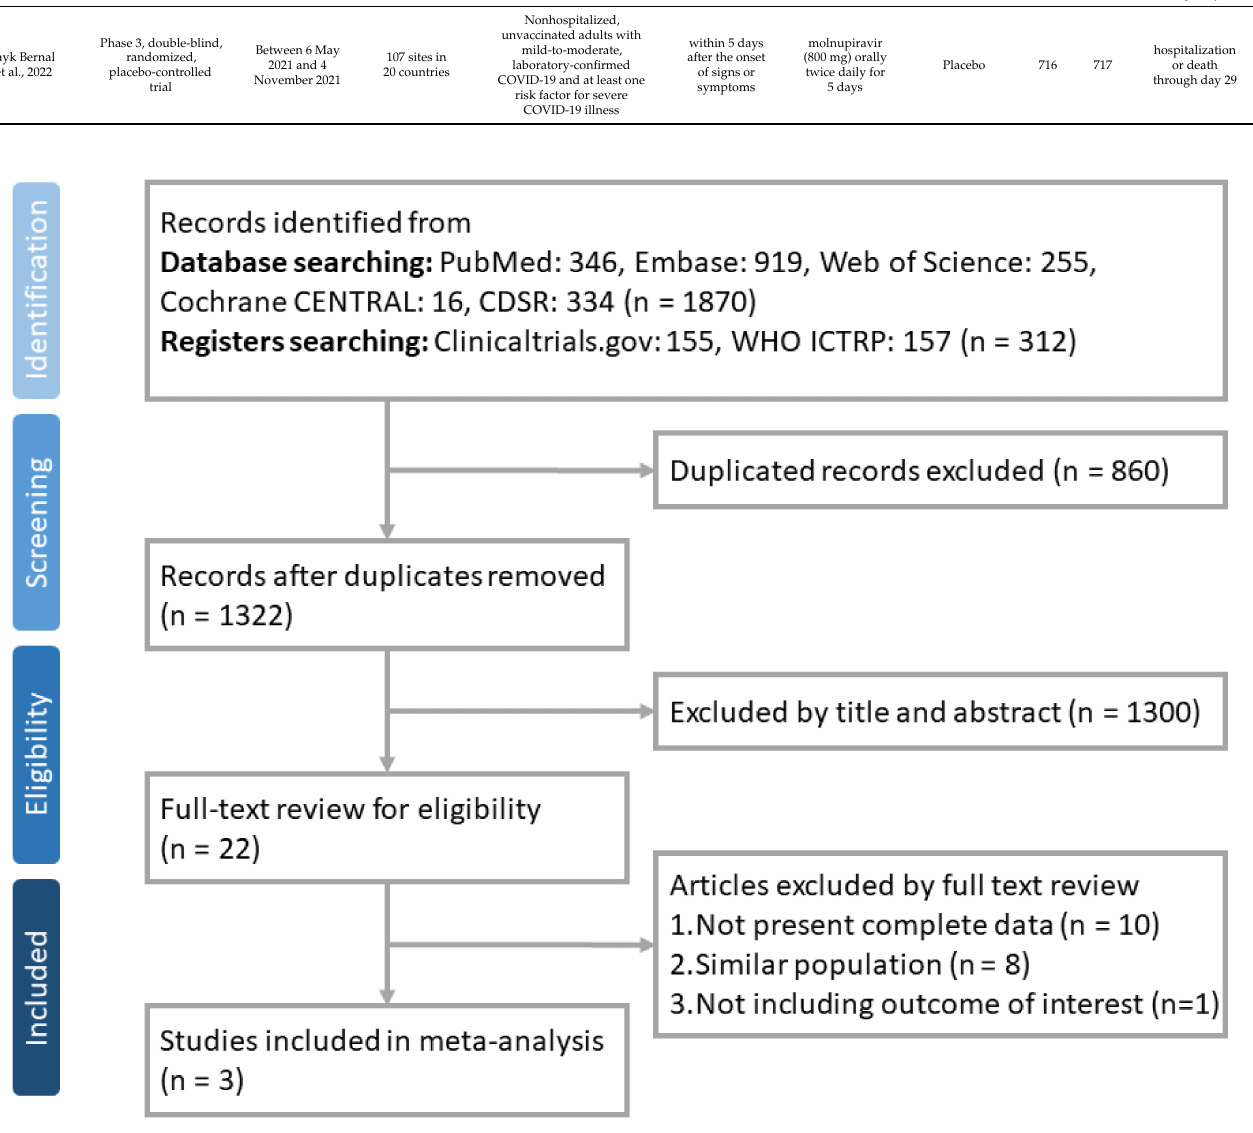
Figure 1. The flow diagram of the identification, inclusion, and exclusion of